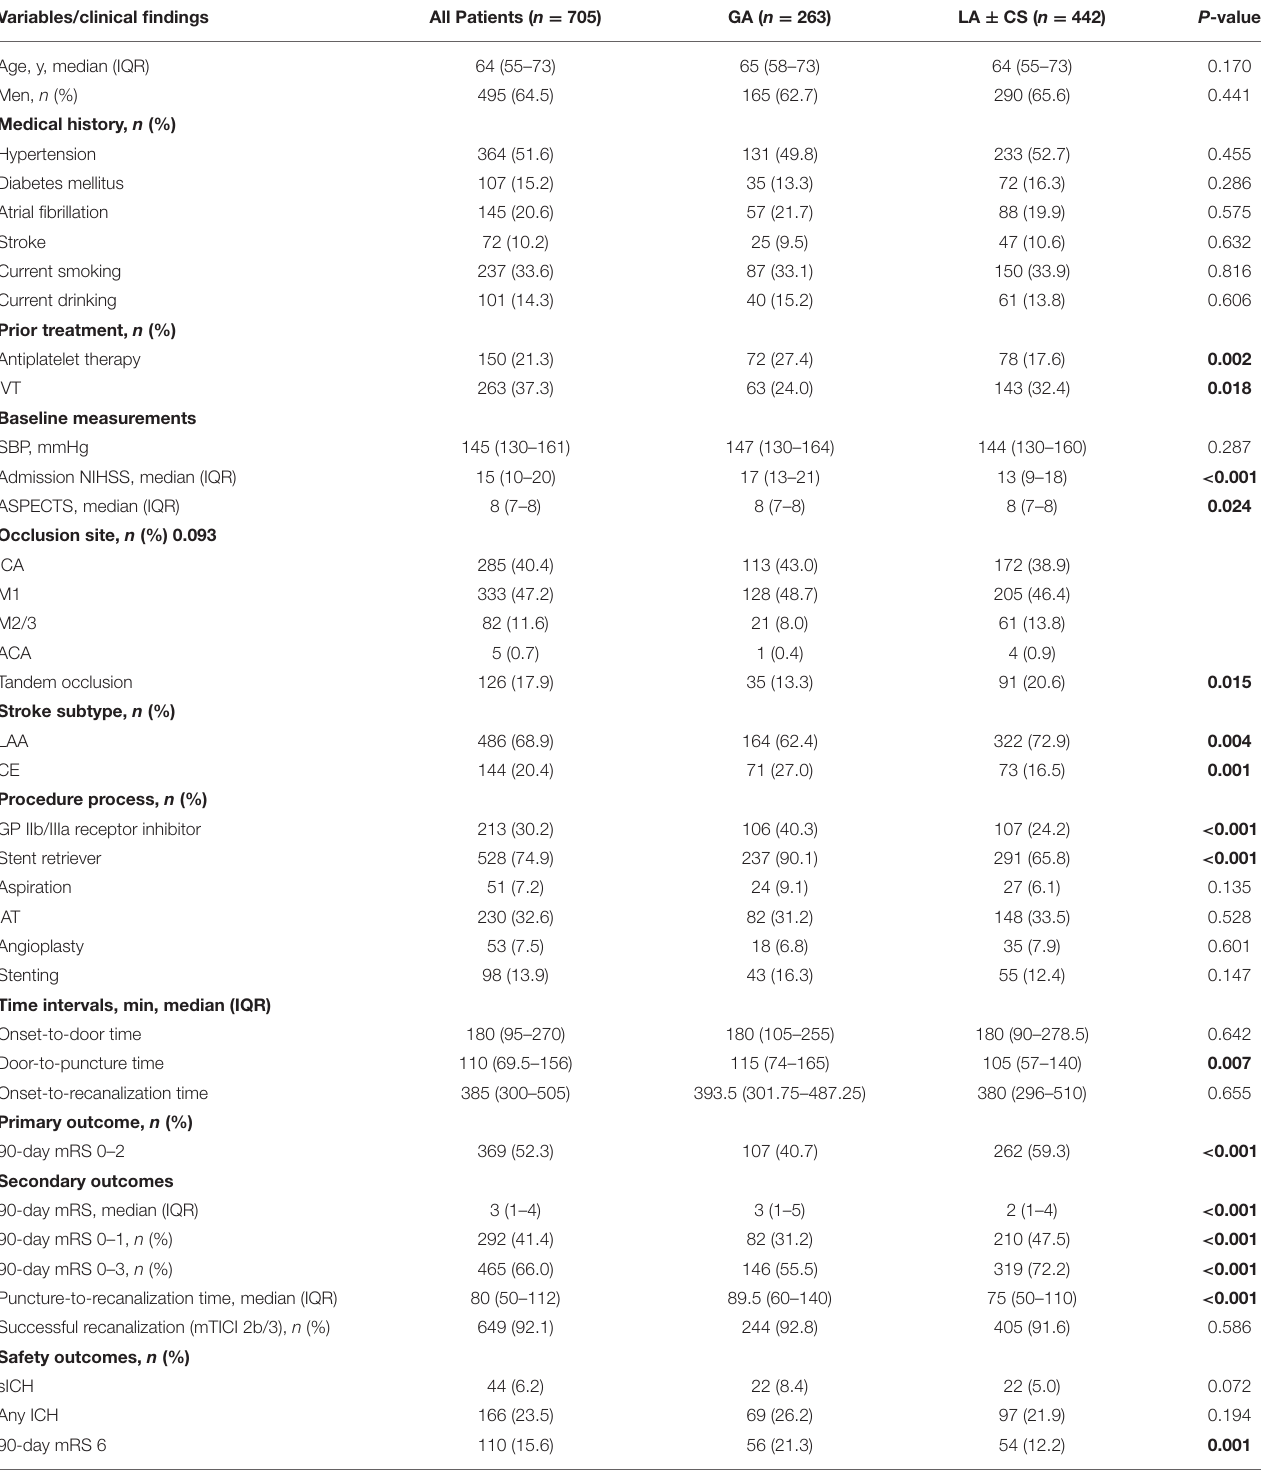
TABLE 1 | Comparison of baseline, procedure, and outcome characteristics between the two groups before PSM. Variables/clinical